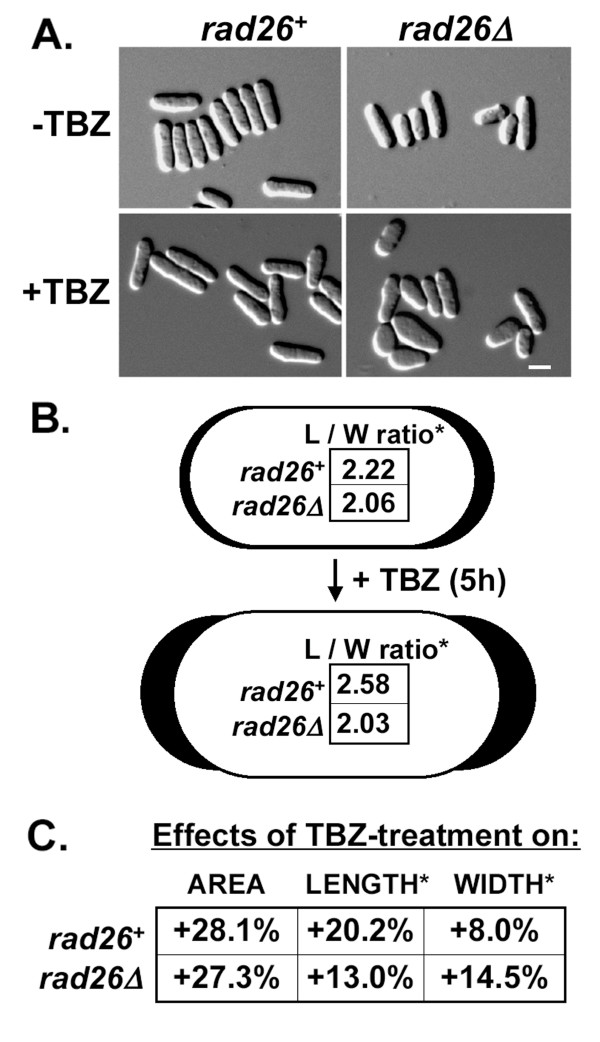
TBZ affected the polarity of rad26Δ cells. A. Images of untreated and TBZ-treated rad26+ and rad26Δ cells. Cultures of rad26+ (TE236) and rad26Δ (TE257) cells were split and left untreated or treated with 20 μg/ml TBZ for five hours, fixed with paraformaldehyde and observed using DIC. B. Interpretive diagram showing that rad26Δ cells were significantly wider (*) than rad26+ cells. The dimensions of untreated and TBZ-treated cells were quantified using Leica FW4000 image analysis software. The length-to-width (L/W) ratios were calculated and presented here in pictorial representations of rad26+ (outlined in black) and rad26Δ (outlined in white) cells. C. The width of rad26Δ cells increased (+) during TBZ-treatment.